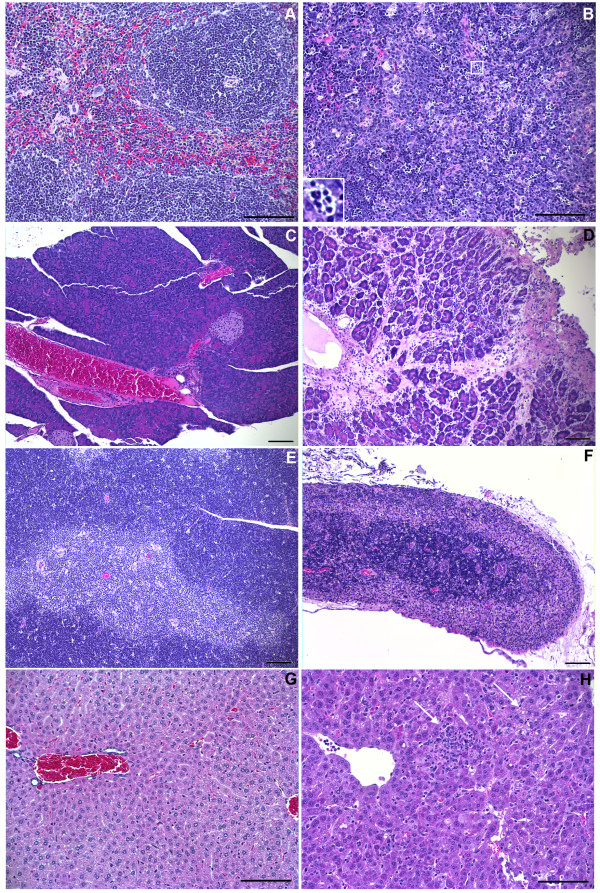
Pathology. Panels on the left of the figure (A, C, E and G) show representative photomicrographs of H&E stained sections of spleen, pancreas, thymus, and liver, respectively, removed from uninfected mice at day 0. Panel B shows the representative disruption of the splenic white pulp architecture at day 7 post-infection, with marked lymphocyte death (example in enlarged inset). Panel D demonstrates pancreatitis, which was observed in all 4 animals at day 7 post infection. Panel F is an example of the complete thymic cortical atrophy observed in all day 7 post-infection mice. Panel H is a representative sample of day 7 liver, demonstrating mild to moderate areas of inflammation and necrosis (left arrow) and regions of hepatocellular degeneration and cell death (right arrow) (Panels A, B, G and H at 200x magnification, scale bar is 50 microns; Panels C, D, E and F, scale bar is 10 microns).